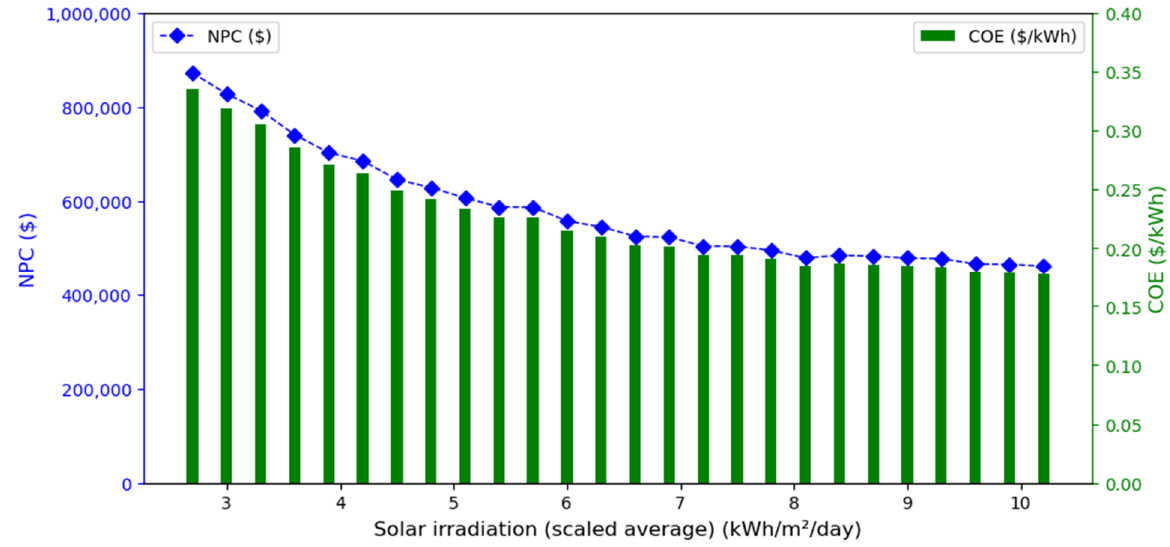
Figure 11. Impact of change in solar radiation value on the PV/WT/battery charging station costs in Sokoto.